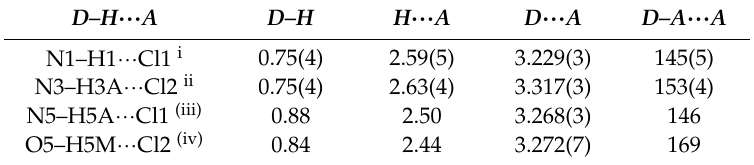
Figure 3. Packing diagram of [Mn{Co( µ -Himn) 3 }Cl 2 (CH 3 OH)] along ( a ) the a axis and ( b ) the b axis. The solvent-accessible void (534 Å 3 /cell) was observed between the hydrogen-bonded sheets (yellow sphere). Solvent molecules of crystallization were removed and regarded as solvent-accessible voids. Table 3. Hydrogen-bond geometry for [Mn{Co(µ-Himn) 3 }Cl 2 (CH 3 OH)]·0.78CH 3 OH·1.26H 2 O (Å , °).